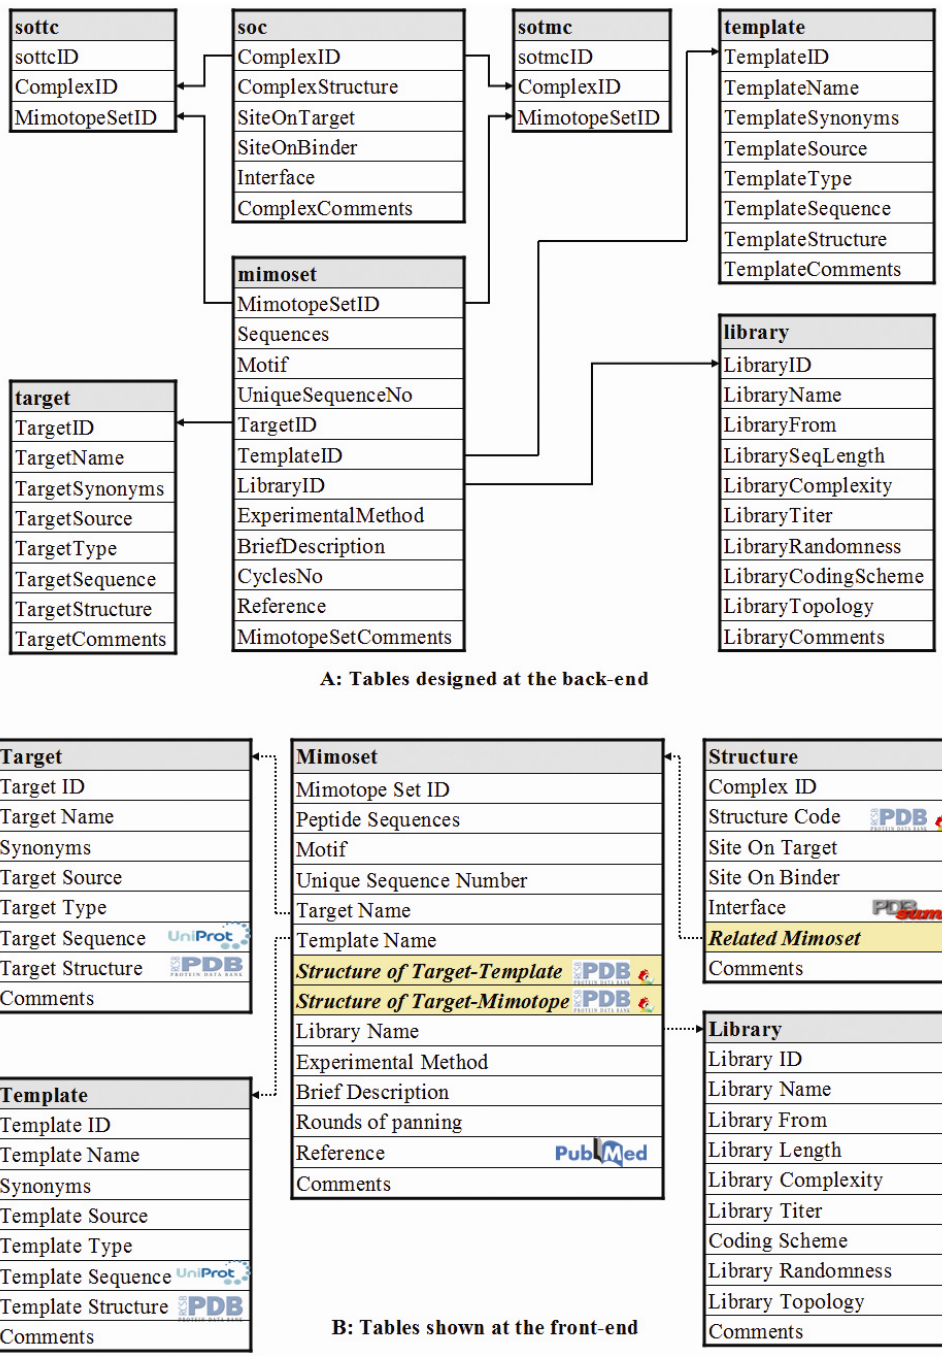
Figure 2. Infrastructure of the MimoDB Database. (A) Tables designed at the back-end. (B) Tables shown at the front-end. The relations among tables at the back-end are shown with solid arrow. Tables shown to users at the front-end are generated on the fly based on the tables and their relations at the back-end. The dotted arrow lines indicate that the content is linked internally to other tables. The logo in a cell means that the content in that cell is hyperlinked to the corresponding external database except the small view icon in the field of Structure Code, which is linked to a molecular visualization tool provided by MimoDB. The cells with background color in sallow indicate fields not existed in the tables at the back-end but added to the table at the front-end